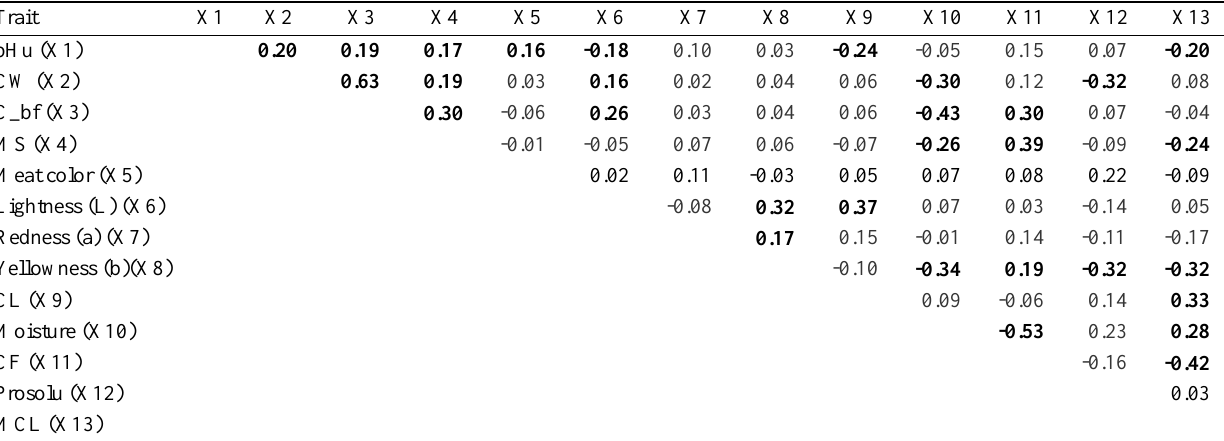
Table 4. Pearson correlation between the traits of meat samples from all breeds Trait